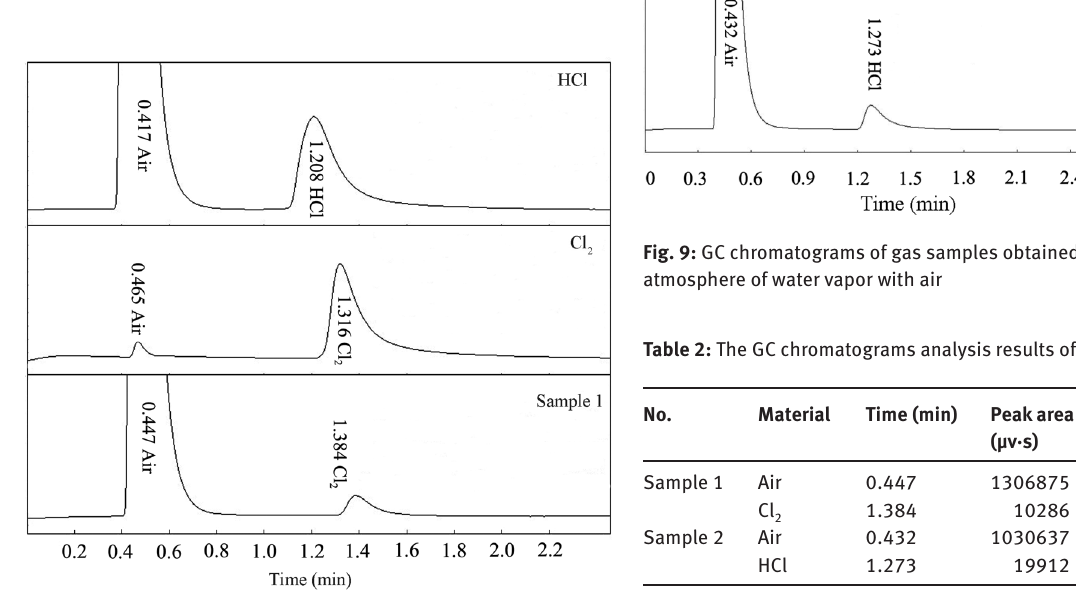
Fig. 7: Dependence of ΔG 0 (T) for Eqs. (1) and (2) with different temperature conditions